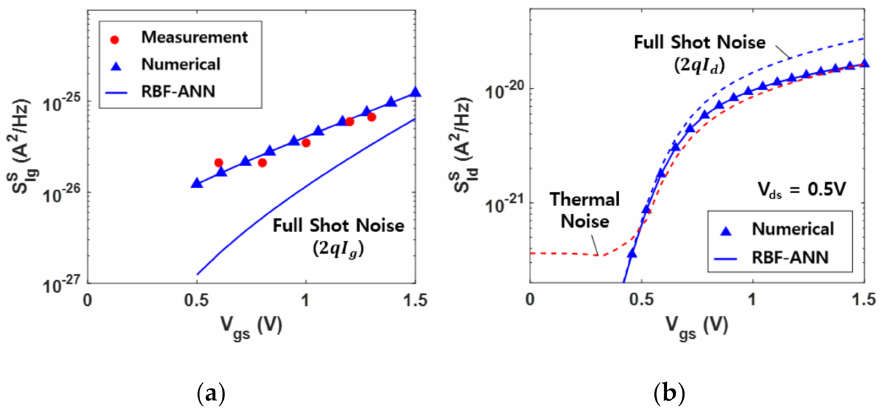
Figure 5. Comparison of measured and numerical data with the results obtained using the RBF- DANN model for ( a ) the gate current shot noise and ( b ) the drain current shot noise.